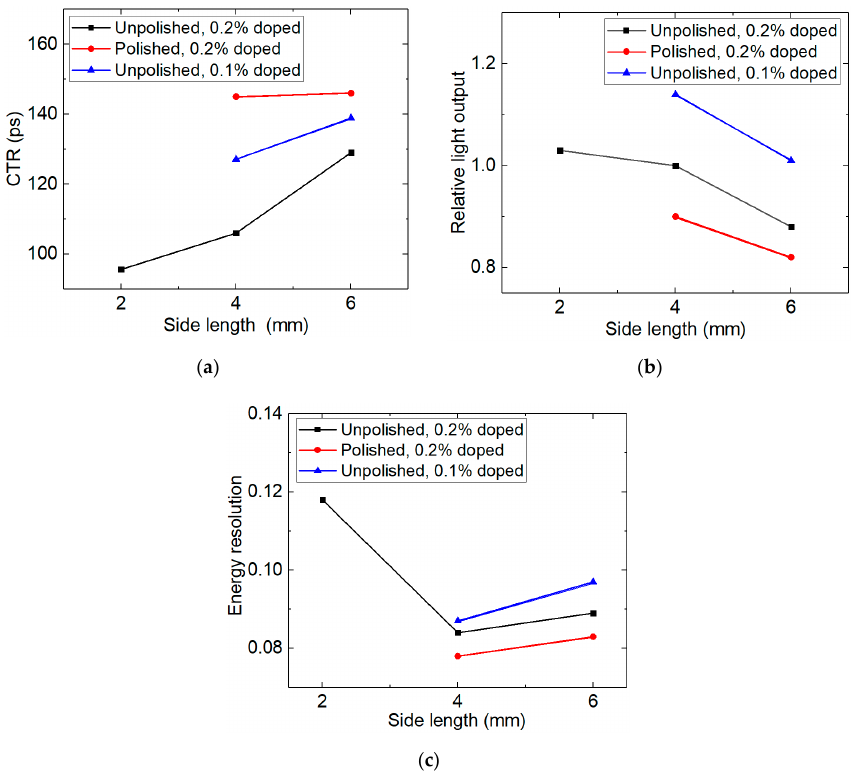
Figure 10. ( a ) CTRs, ( b ) relative light outputs and ( c ) energy resolutions of 2 mm, 4 mm and 6 mm side LYSO cubes